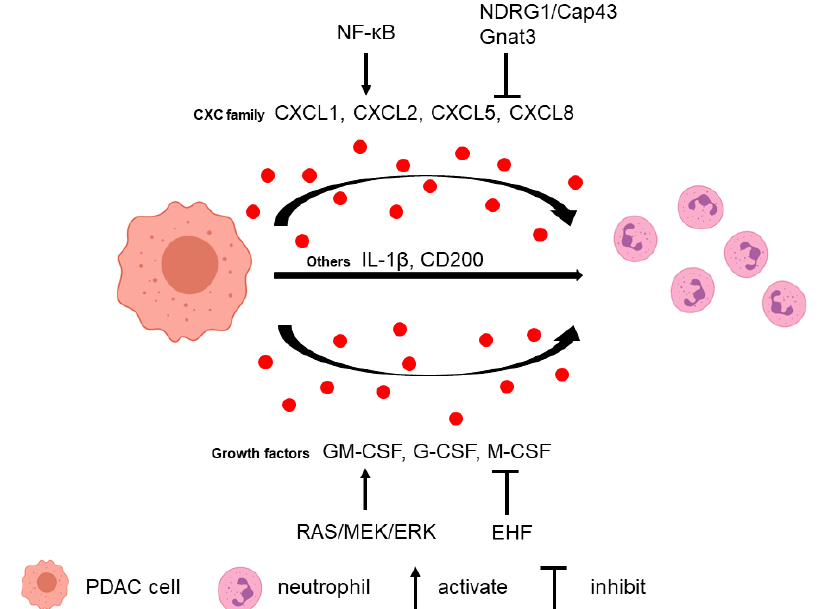
Figure 1. Tumor cell-secreted factors attract neutrophils. Tumor cells can release several factors to recruit neutrophils, such as the CXC family (CXCL1, CXCL2, CXCL5, and CXCL8), growth factors (GM-CSF, G-CSF, and M-CSF), IL-1 β , and CD200. Different pathways regulate these factor secretions.